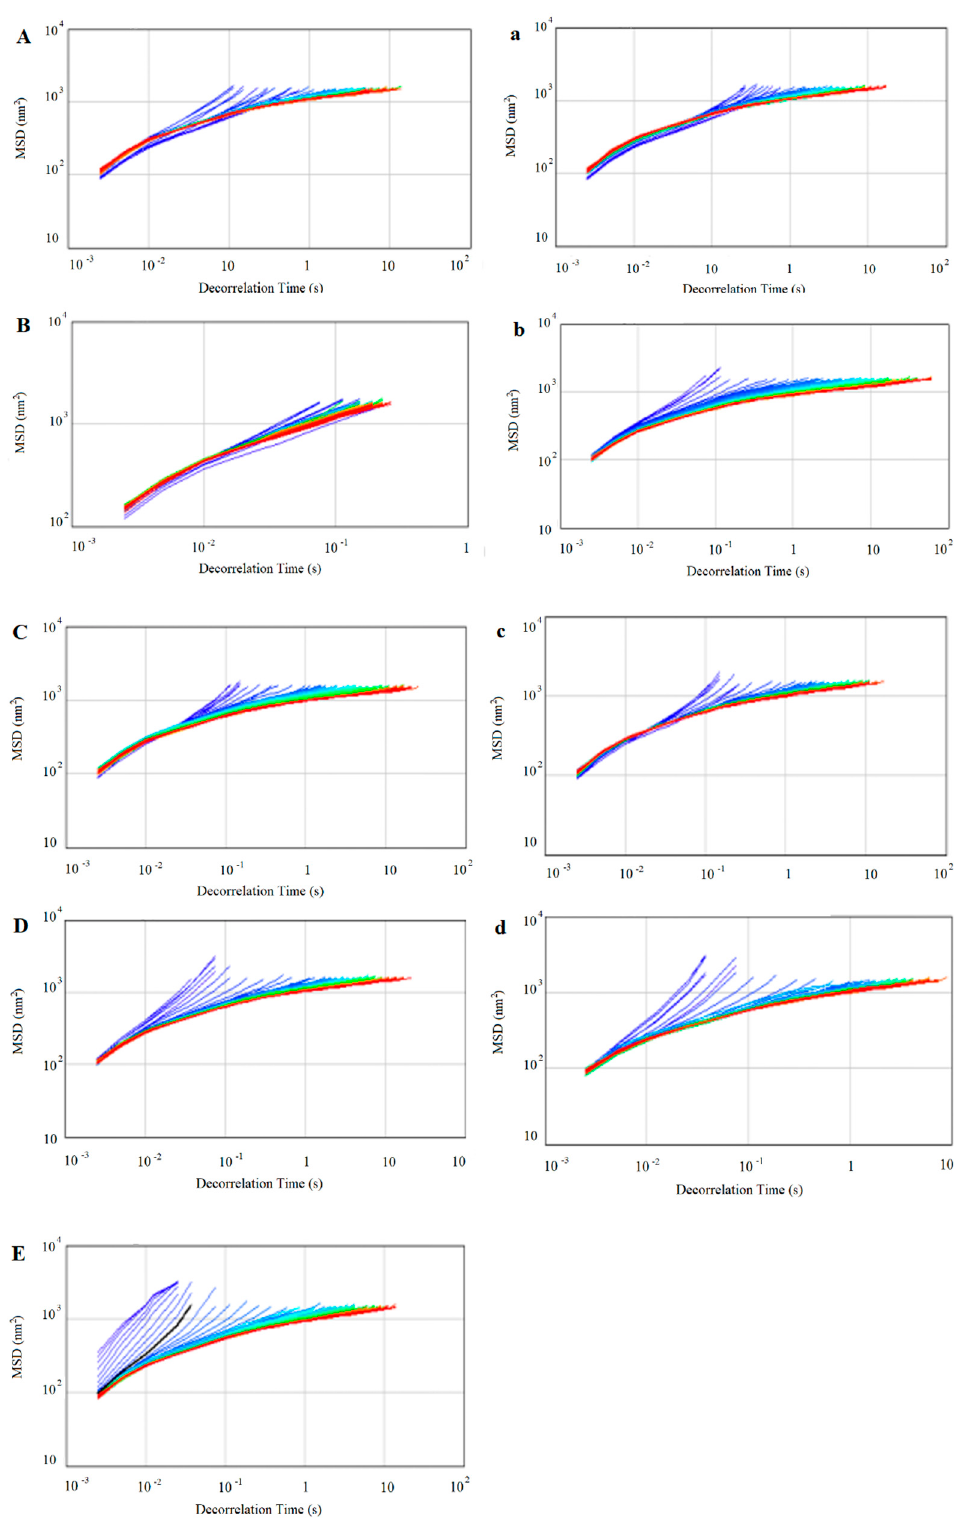
Figure 7. Microrheological curves of RDCs with different PGEs. ( A – D ) 0.7% concentration of TMS, TML, PGE55, and PMS; ( a – d ) 0.9% concentration of TMS, TML, PGE55, and PMS; ( E ) RDC without PGE.